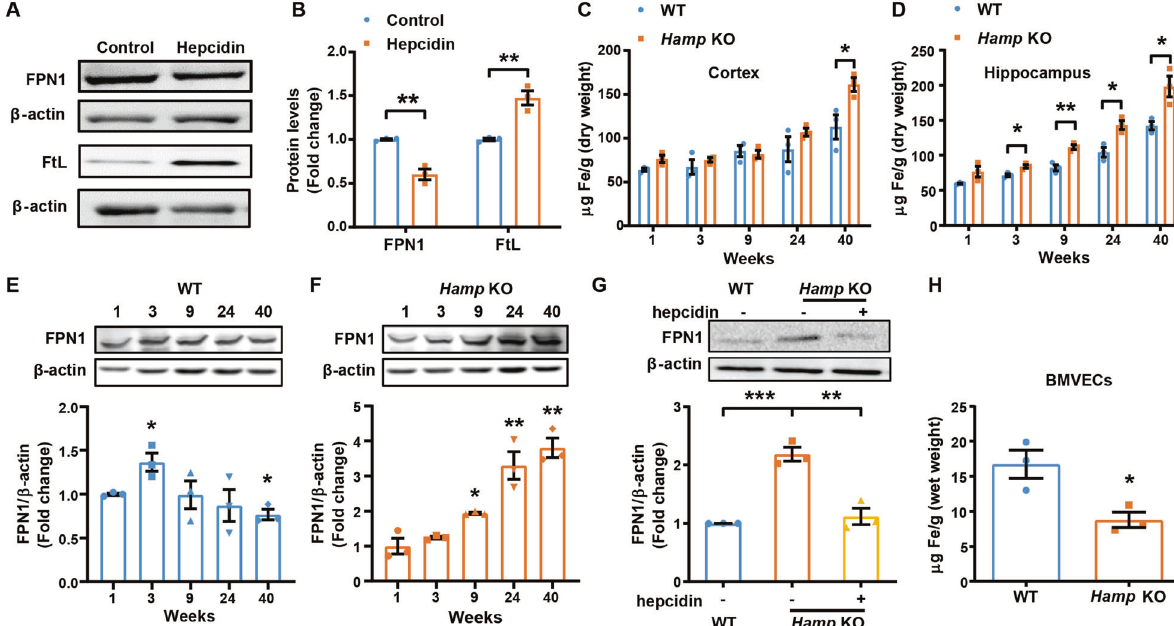
Fig. 2 Hepcidin regulates the levels of FPN1 of BMVECs. A is western blot analysis of FPN1 and ferritin levels in BMVECs 24 h following ICV injection of hepcidin into 3-month-old WT mice. B is the relative expression levels of FPN1 and ferritin in control and hepcidin-treated mice calculated after they were normalized to β -actin levels and expressed as the mean ± SEM. n = 3, ** p < 0.01. C , D are the total iron in the cerebral cortex ( C ), hippocampus ( D ) of Hamp KO or control WT mice of the indicated ages determined by ICP-MS. Values are presented as the mean ± SEM, n = 3, * p < 0.05 and ** p < 0.01. E is the FPN1 protein levels in BMVECs of WT mice of the indicated ages. The relative expression levels were expressed as the mean ± SEM, n = 3, * p < 0.05 vs. 1-week-old mice. F is the FPN1 protein levels in BMVECs of Hamp KO mice of the indicated ages. The relative expression levels were expressed as the mean ± SEM, n = 3, * p < 0.05 and ** p < 0.01 vs. 1-week-old mice. G is the protein levels of FPN1 in BMVECs measured by western blot analysis following ICV injection of hepcidin in 24-week-old Hamp KO and WT mice. The relative expression levels were normalized and expressed as the mean ± SEM, n = 3, ** p < 0.01 and *** p < 0.001. H is total iron level in BMVECs determined by ICP-MS in 24-week-old Hamp KO and WT mice. The values are presented as the mean ± SEM, n = 3, * p < 0.05 vs. WT